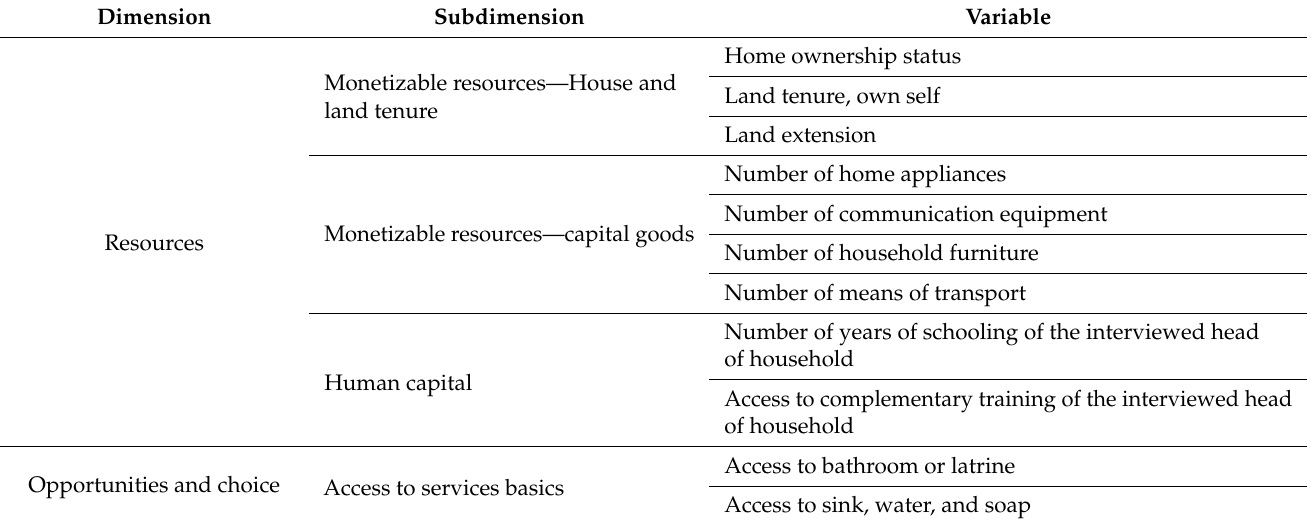
Table 2. Variables of the Multidimensional Poverty Index for the city of